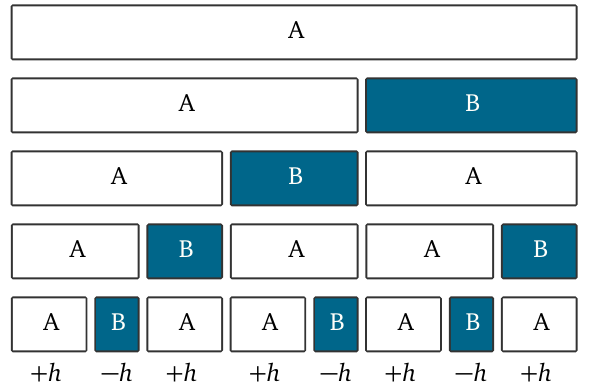
Figure 1: The first five Fibonacci words, depicted as horizontal chains of rectangular tiles. Applying the substitution rule σ to a word yields the next, represented just below it. Below the largest word is printed the corresponding sequence of on-site potentials ± h